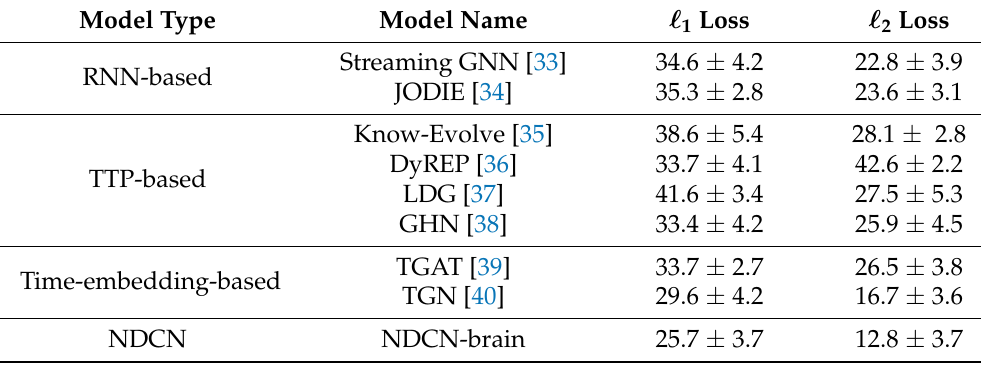
Table 6. Comparison with continuous dynamic network